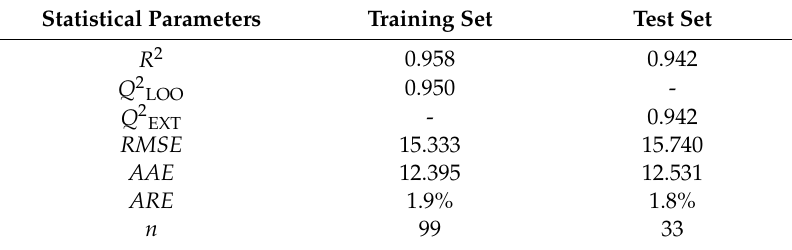
Table 2. The main statistical parameters of the obtained Multiple Linear Regression (MLR) model.